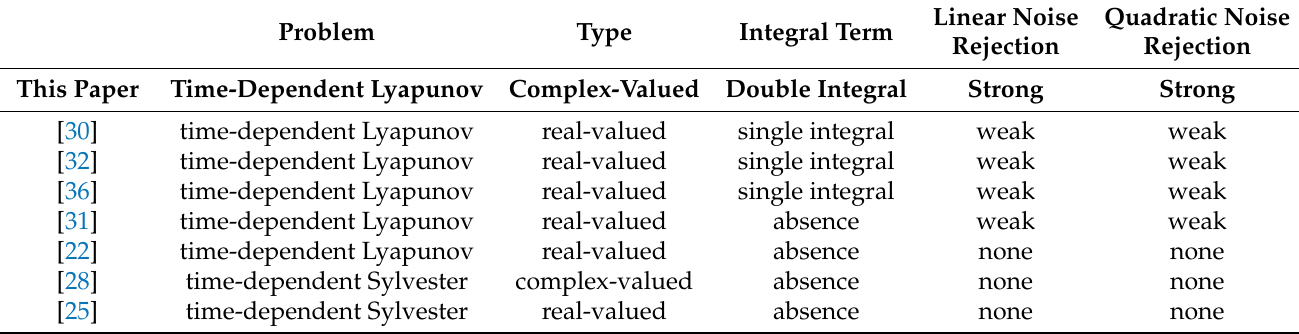
Table 1. Comparison between the present study and the previous